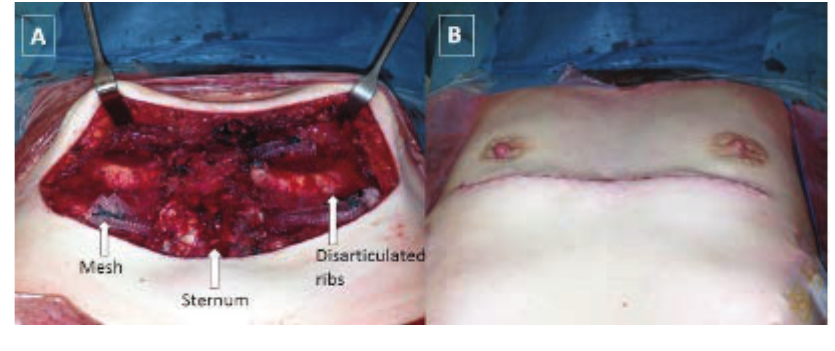
Figure 5. Open repair of a severe pectus excavatum deformity with a modified Ravitch technique. Following insertion of a mesh (A) and after skin closure